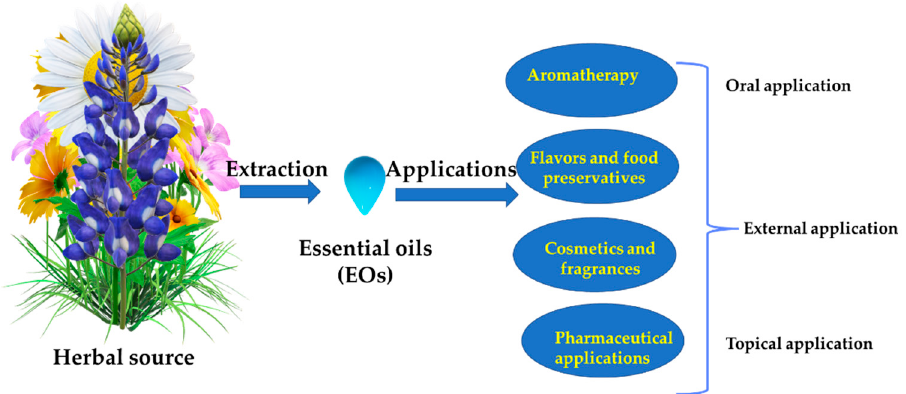
Figure 2. Outline of various applications and administration routes for EOs.